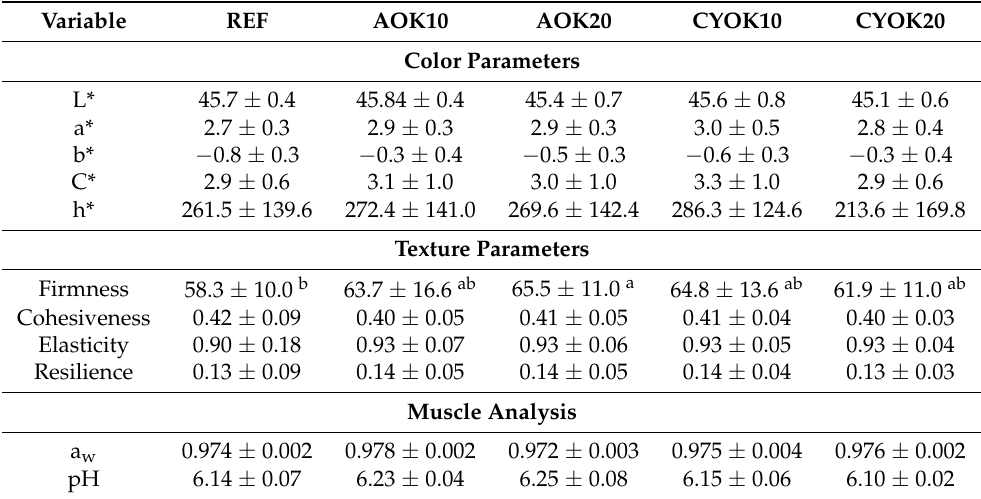
Table 7. Instrumental texture and color analysis, water activity (a W ), and pH of raw fillets of Nile tilapia fed the experimental diets for 10 weeks.